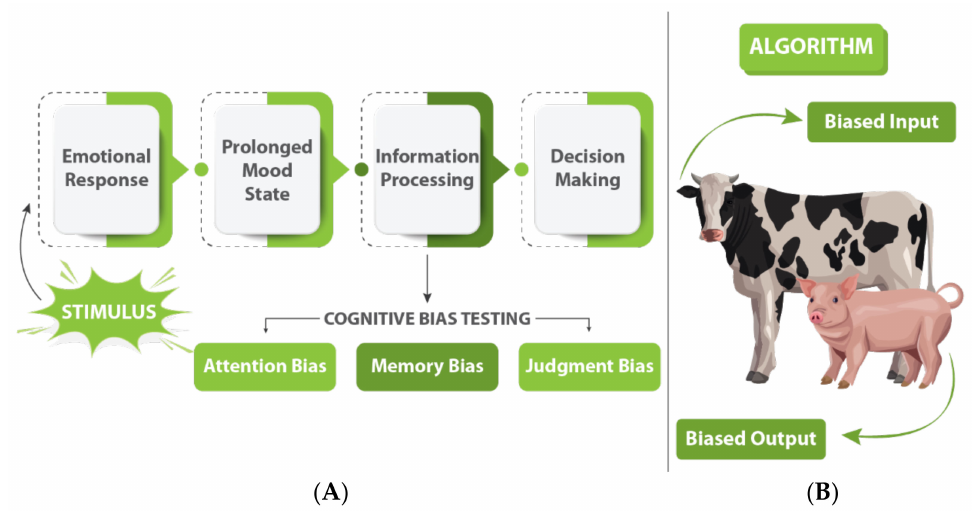
Figure 6. ( A ) Typical experimental paradigm for farm animal cognitive bias tasks. ( B ) Impact of bias in machine learning algorithm on animal emotion